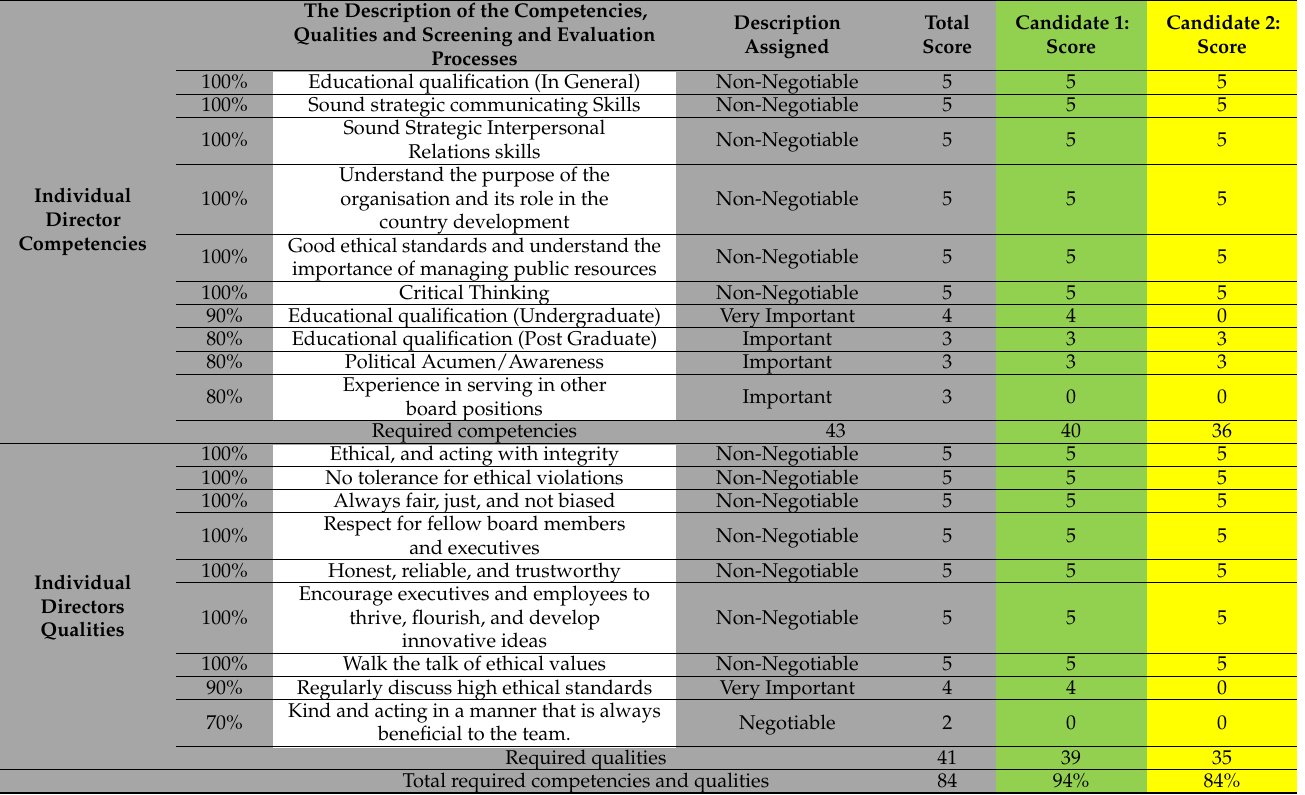
Table 4. Illustrative example showing how to score individual director competencies and